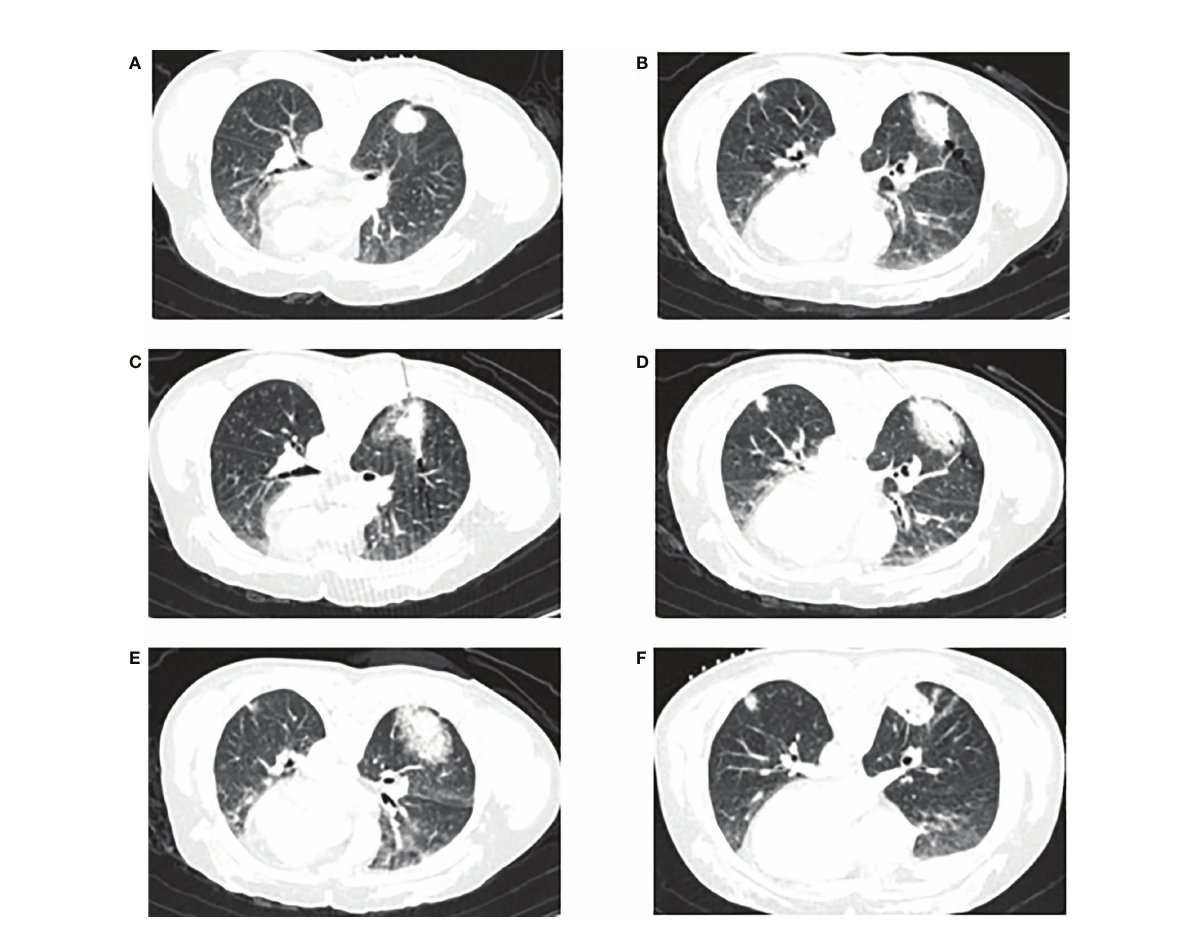
FIGURE 4 CT-guided percutaneous CA. (A) CT scan performed before CA, showing a lesion in the lower right lobe. (B – E) CT − guided percutaneous CA of the lesion. (F) CT scan performed 1 month after the